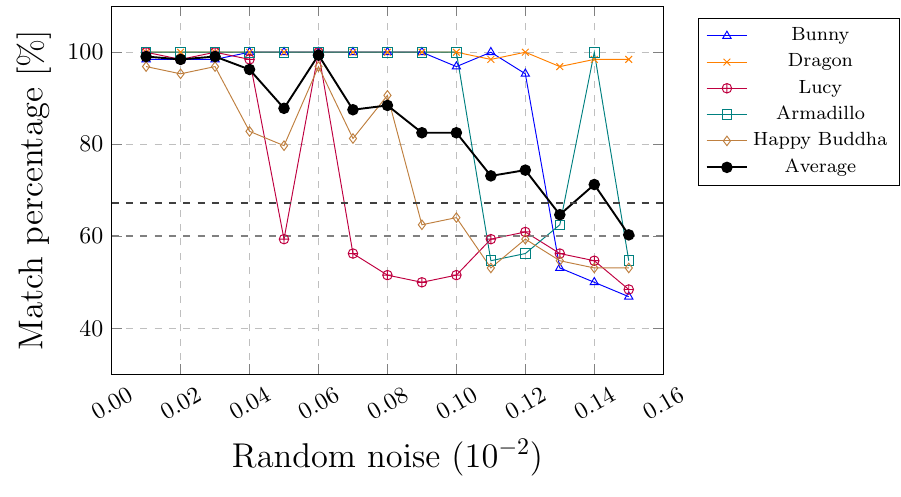
Figure 11. Global noise attack. Table 7. Combined attacks with noise added locally between 0.02 and 0.26 and a maximum noise added globally between 0.0001 and